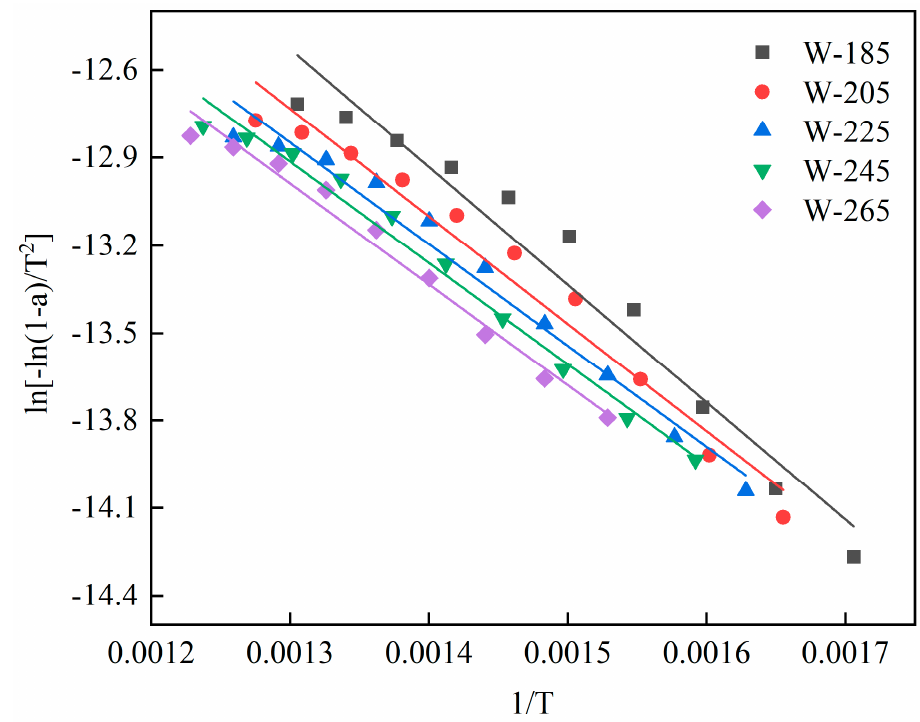
Figure 9. Fitting curves for pyrolysis of hydrochar produced at increasing HTC temperatures Figure 9. Fi tt ing curves for pyrolysis of hydrochar produced at increasing HTC temperatures (185– 265 °C) under the main weightlessness interval. (185–265 ◦ C) under the main weightlessness Table 3. Kinetic parameters of hydrochar pyrolysis at di ff erent HTC temperatures.